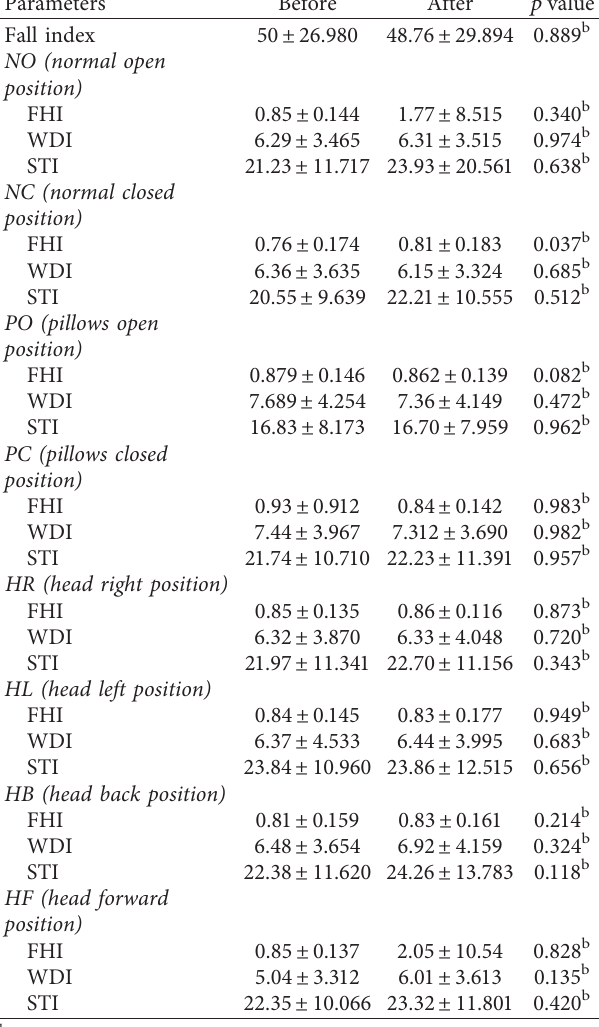
Table 1: Perioperative comparison of visual acuity, pachymetry, intraocular pressure, and visual field values of all eyes.